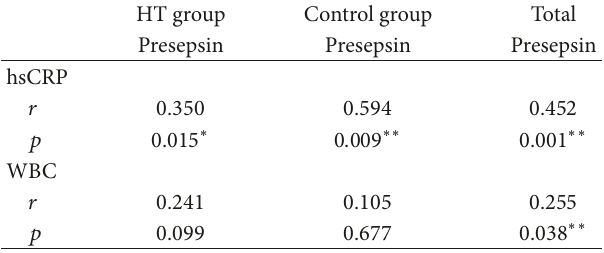
Table 2: Correlation analysis between presepsin and other inflam- matory markers.